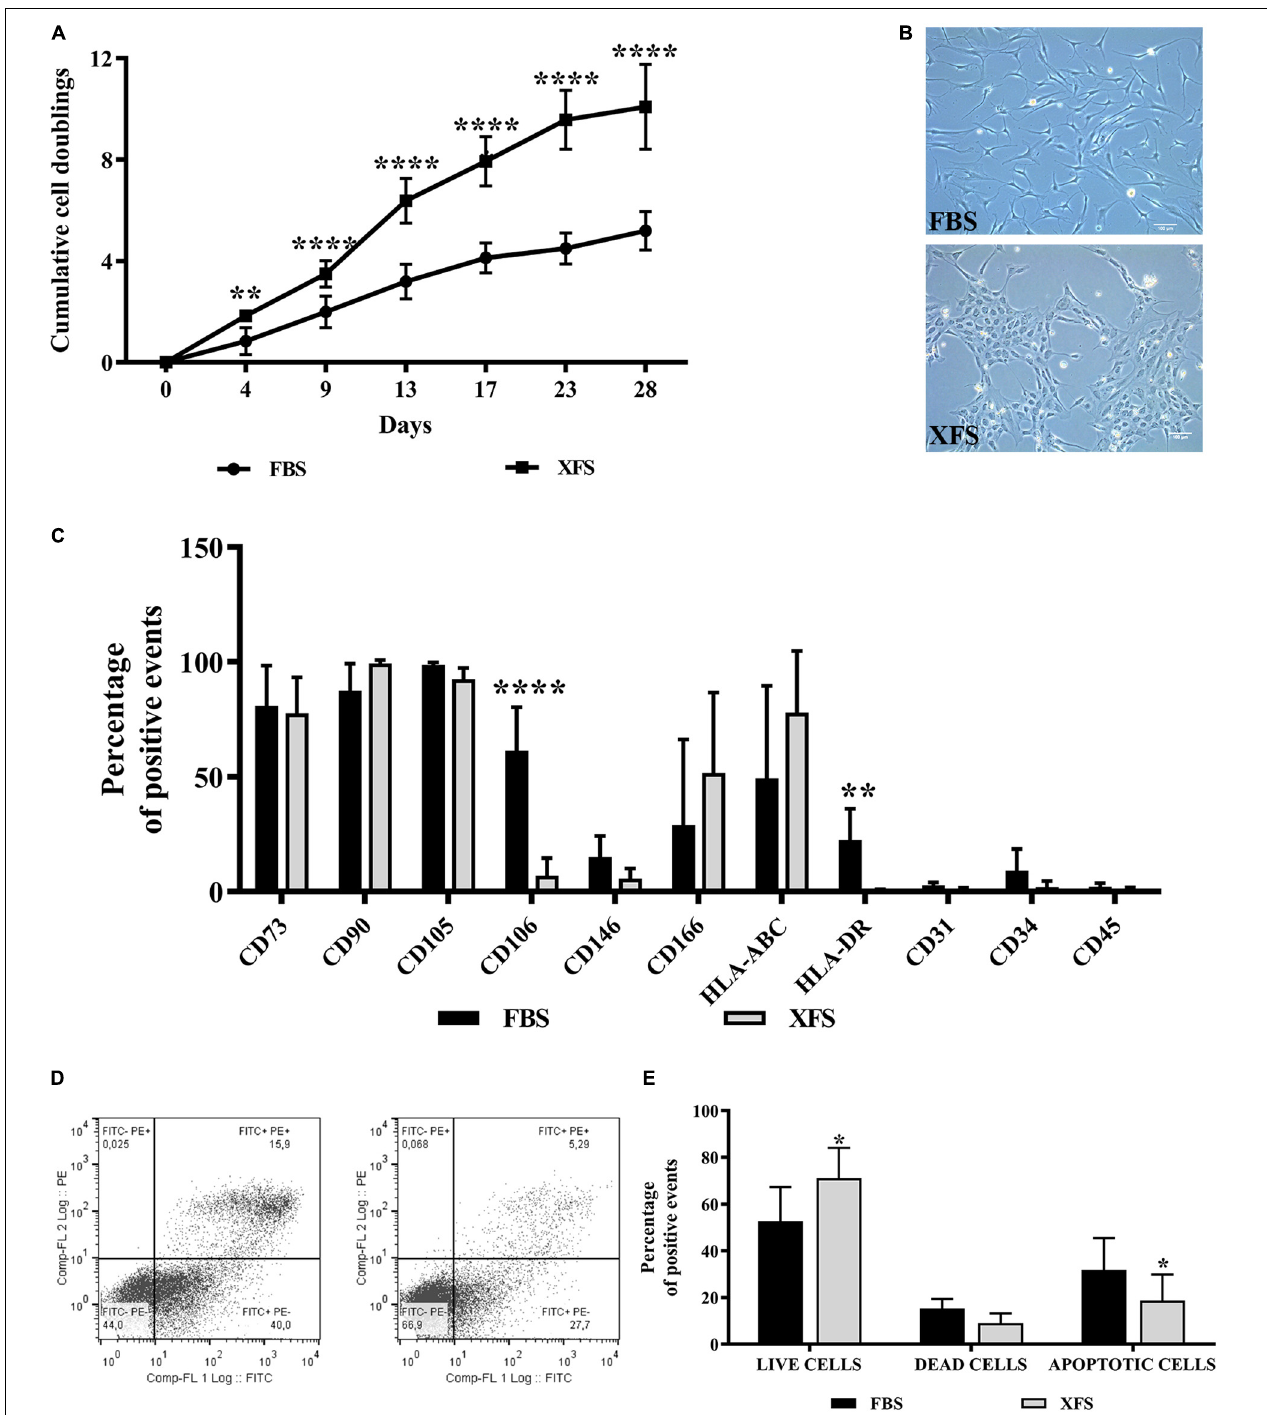
FIGURE 1 | Characterization of hBMSCs cultured in FBS- or XFS-containing medium. (A) Proliferation of hBMSCs grown in FBS or XFS-containing medium (6 donors). Growth kinetics expressed as the cumulative number of cell duplications in relation to the culture time. ** P < 0.01, **** P < 0.0001, t -test. (B) Microscope images showing the morphology of the cells. Images were acquired with a phase contrast Leica DMi1 microscope using a 10 × magnification (scale bar 100 µ m). (C) Flow cytometry analysis of hBMSCs cultured in the presence of FBS- or XFS-containing medium. The average percentage of positive events of each marker is reported in a histogram, indicating the mean ± SD of three independent experiments. ** P < 0.01, **** P < 0.0001, t -test. (D) Detection of apoptosis by concurrent staining with FITC-anti-annexin V and PI of hBMSCs grown in FBS- (left panel) or XFS-containing medium (right panel). (E) Quantification of flow cytometry data. The histogram shows the mean ± SD of six independent experiments. * P < 0.05, t -test.